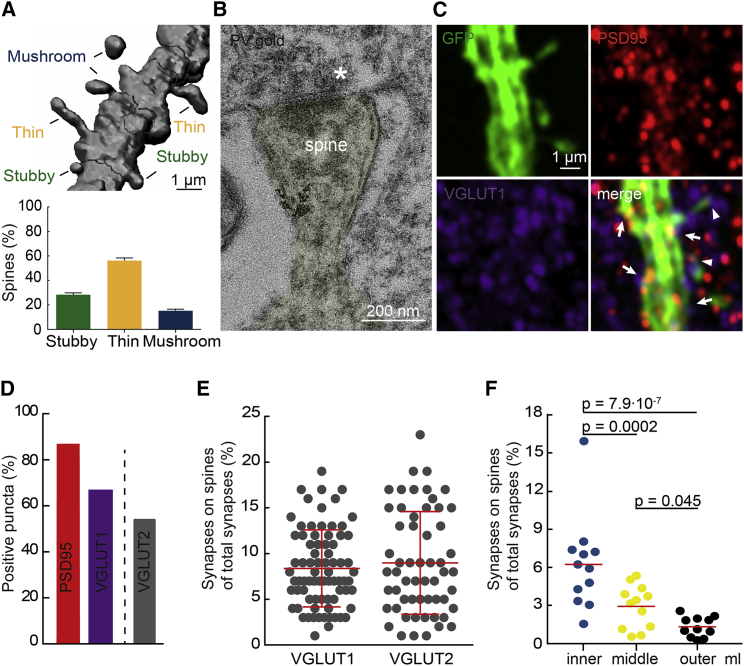
Dendritic Spines Participate in Synapse Formation(A) PVI spines show stubby, thin, and mushroom morphologies. Top, example of a 3D-reconstructed segment. Bottom, thin spines were more abundant than stubby and mushroom spines (n = 5,700 spines, 57 cells, 6 mice).(B) Electron micrograph showing a PV-immunogold-labeled spine (yellow) forming an asymmetrical synapse (asterisk).(C) Single-plane confocal images showing immunoreactivity for GFP (green), PSD95 (red), and VGLUT1 (blue) in the ml. Examples of PSD95-positive puncta in shafts and spines apposed to VGLUT1 positive boutons (arrows and arrowheads, respectively) represent putative synapses.(D) About 90% of all spines were positive for PSD95 and apposed to VGLUT1- or VGLUT2-positive terminals (n = 1,960 spines, 29 neurons, 3 mice).(E) The percentages of VGLUT+/PSD95+ putative spine synapses over all synapses (shaft and spine) varied in individual spiny segments (n = 134 segments, 29 neurons, 3 mice) and (F) depended on the molecular sublayer when quantified for entire dendritic trees (n = 12 neurons, 3 mice); bars are means, and error bars show SD.